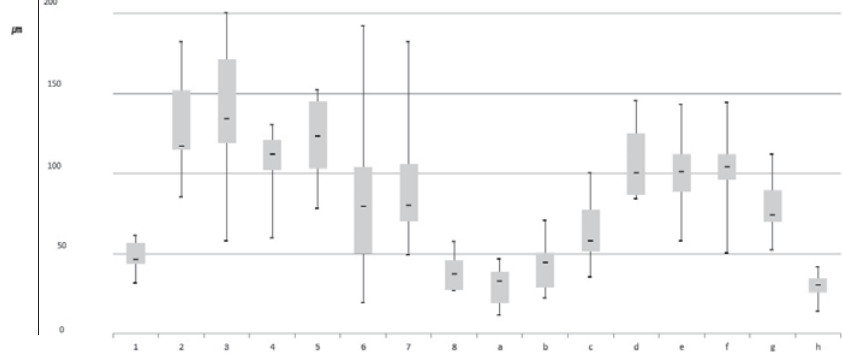
Figure 4- (cid:3)(cid:36)(cid:70)(cid:70)(cid:88)(cid:85)(cid:68)(cid:70)(cid:92)(cid:3)(cid:82)(cid:73)(cid:3)(cid:191)(cid:87)(cid:3)(cid:82)(cid:73)(cid:3)(cid:72)(cid:68)(cid:70)(cid:75)(cid:3)(cid:80)(cid:72)(cid:68)(cid:86)(cid:88)(cid:85)(cid:76)(cid:81)(cid:74)(cid:3)(cid:83)(cid:82)(cid:76)(cid:81)(cid:87)(cid:3)(cid:76)(cid:81)(cid:3)(cid:74)(cid:85)(cid:82)(cid:88)(cid:83)(cid:3)(cid:21)(cid:3)(cid:11)(cid:38)(cid:40)(cid:53)(cid:40)(cid:38)(cid:3)(cid:54)(cid:58)(cid:3)(cid:22)(cid:17)(cid:27)(cid:15)(cid:3)(cid:27)(cid:19)(cid:3) (cid:80) m). Uppermost point and lowermost point indicate the highest and lowest values of results. The top of box and bottom of box indicate the 75% and 25% values of results. The midline in the box means the average of the results